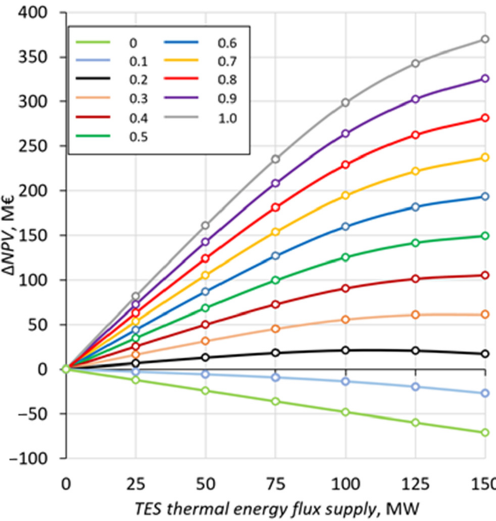
Figure 13. NPV as a function of project lifetime for the three values of deviation index (left = − 0.2/0.2, central = − 0.5/0.5, and right = − 0.8/0.8).